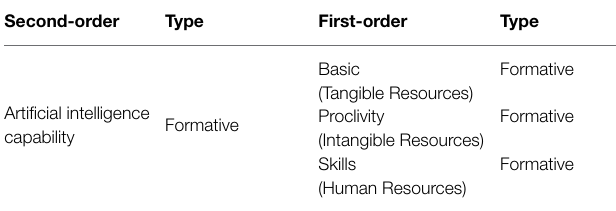
TABLE 2 | The formative construct of AIC.